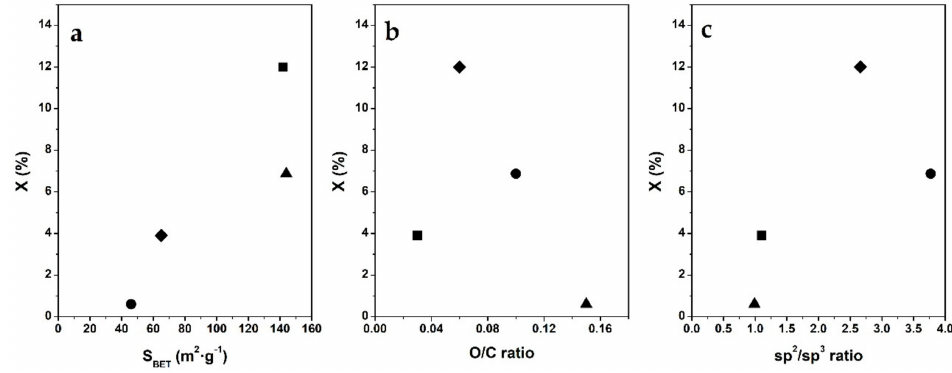
Figure 9. Correlations of the C@Fe–Al 2 O 3 hybrid samples: ( • ) C@Al-723, ( Figure 8. Reaction profiles of the C@Fe–Al 2 O 3 hybrid samples: (  ) C@Al-723, (  ) C@Al-823, (  ) C@Al-923, and (  )